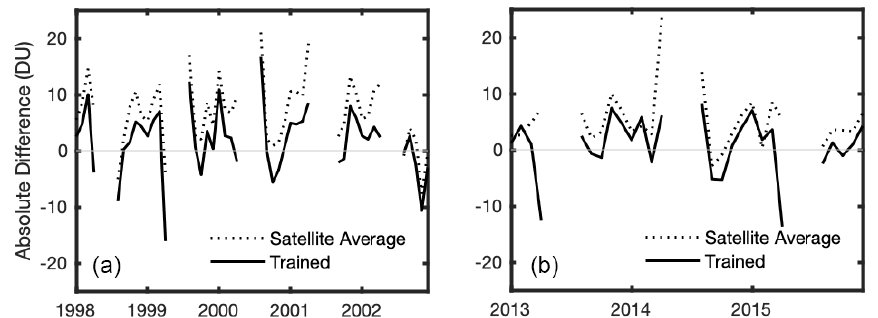
Figure 5. The monthly mean of the absolute difference between the ozone columns, retrieved from Halley Dobson daily ozone averages and the satellite average (dotted) as well as the difference between the trained satellite average (solid) and the Dobson observations for the periods (a) 1998–2002 and (b) 2013–2015.